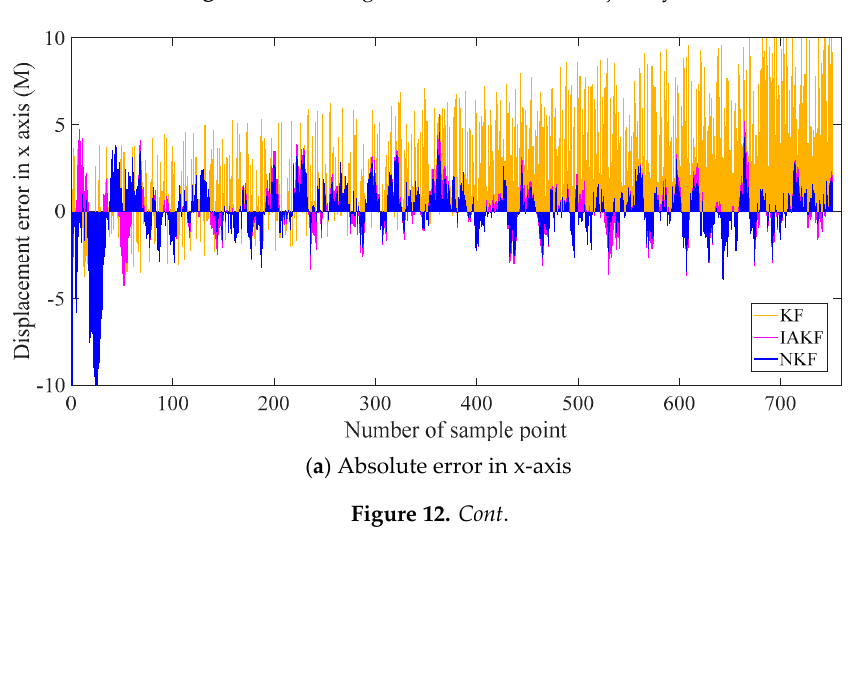
Figure 11. Filtering results of the whole trajectory.